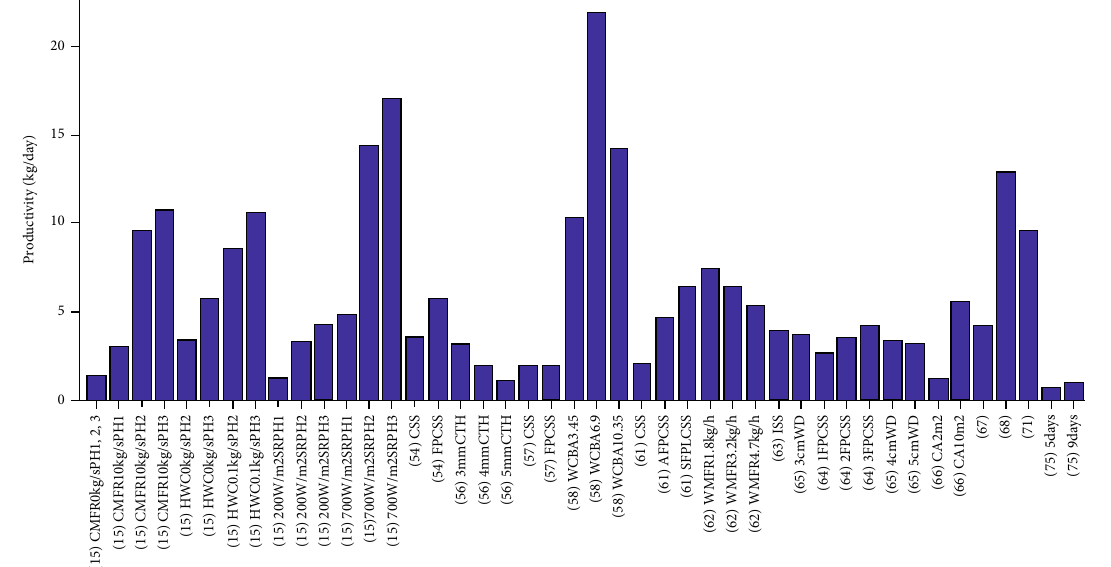
Figure 33: Productivity of di ff erent types of solar